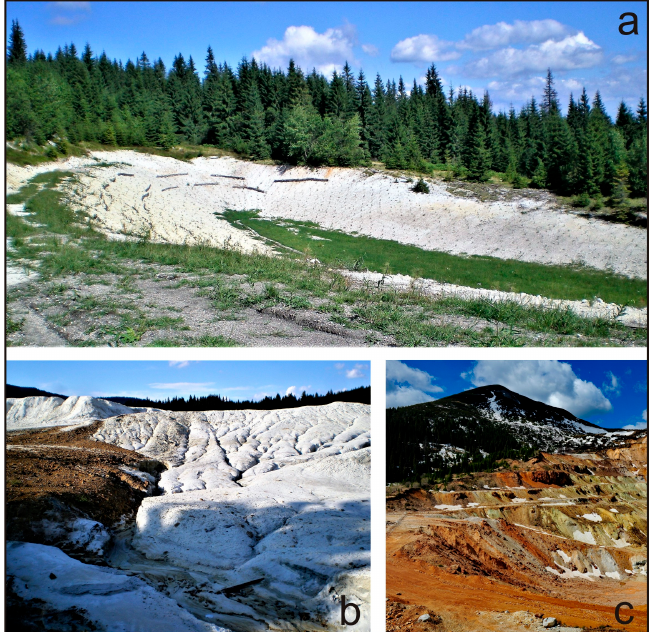
Figure 20. Anthropic landscapes in the C ă limani-Gurgiu-Harghita volcanic range: ( a ) recultivated area of former mercury exploration quarry at Sântimbru-B ă i (South Harghita Mountains), ( b ) tailing pond remnants of underground ”caoline” mining at Harghita-B ă i (North Harghita Mountains), ( c ) spoiled landscape at the Negoiul Românesc intra-caldera stratocone in the C ă limani due to open pit sulfur extraction works; Pietricelul dacite dome on the caldera rim at the upper left. (Photo credit: Péter Lengyel). Being lower in altitude and more accessible, the North Harghita landscape was a bit more affected by anthropic activities, as compared to the Gurghiu Mountains. Mining ex- ploration and extraction works, for instance, affected quite large areas: “caoline” (in fact illite) mining at Harghita-B ă i left behind a landscape-spoiling tailing pond (Figure 20b), and mineral exploration works resulted in smaller wounds within the larger central de- pression of the Vârghi ş volcano. The Zetea dam, and the accumulation lake behind, at the northern junction with the Gurghiu Mountains significantly modified the local landscape. Ski resort areas at Harghita-B ă i, Homorod-B ă i, and, most significantly, high up on the Vârghi ş volcano, close to its highest topographic elevation of the Harghita M ă d ă ra ş sum- mit, with their infrastructures and tourist facilities, represent relevant examples of an- thropically-modified/spoiled landscape in the North Harghita Mountains. The old health- spa area of Harghita-B ă i is another typical example. The Ş umuleu-Ciuc dome is located in a high-density anthropic environment and it (namely the saddle behind the smaller Ş umuleu Mic dome) is the site of Christian cultic (i.e., the traditional late-spring pilgrim- age) and other cultural events several times every year, resulting in a strong and evolving imprint on the local natural landscape. The South Harghita Mountain landscape is even more intensely modified and mod- eled by anthropic activities, including remnants of more-or-less remediated mineral ex-